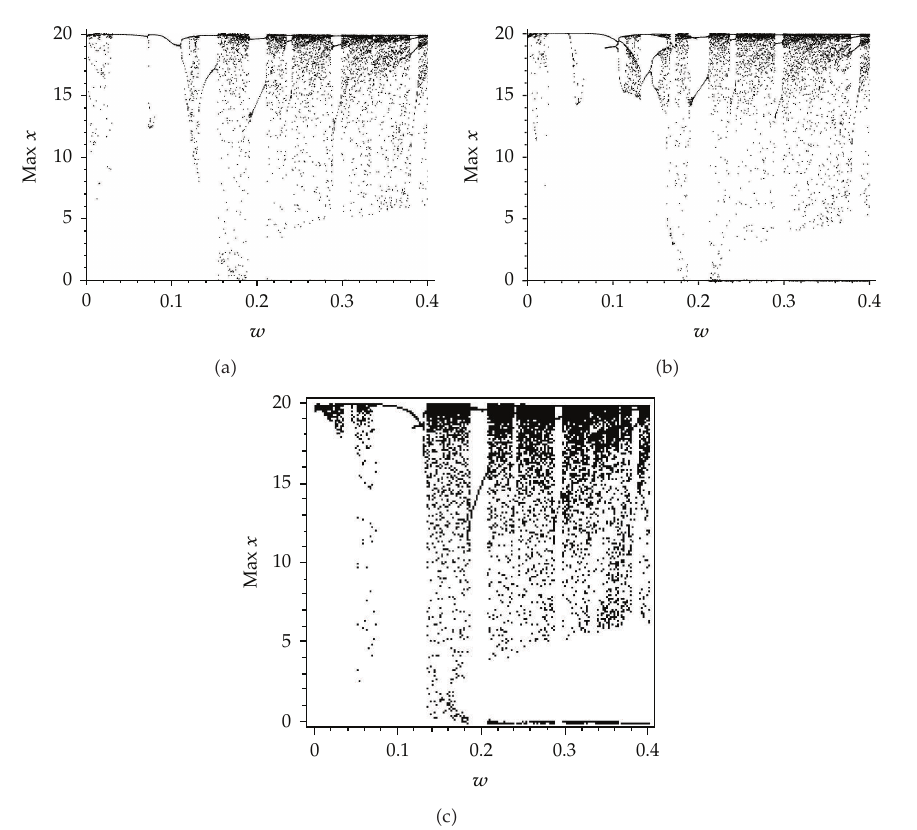
Figure 4: Bifurcation diagram of system (cid:7) 1.1 (cid:8) with initial conditions x 0 (cid:6) (cid:7) 0 . 1 , 0 . 1 , 0 . 1 (cid:8) . (cid:7) a (cid:8) ϕ (cid:6) 0; (cid:7) b (cid:8) ϕ (cid:6) (cid:7) π/ 2 (cid:8) ; (cid:7) c (cid:8) ϕ (cid:6) π